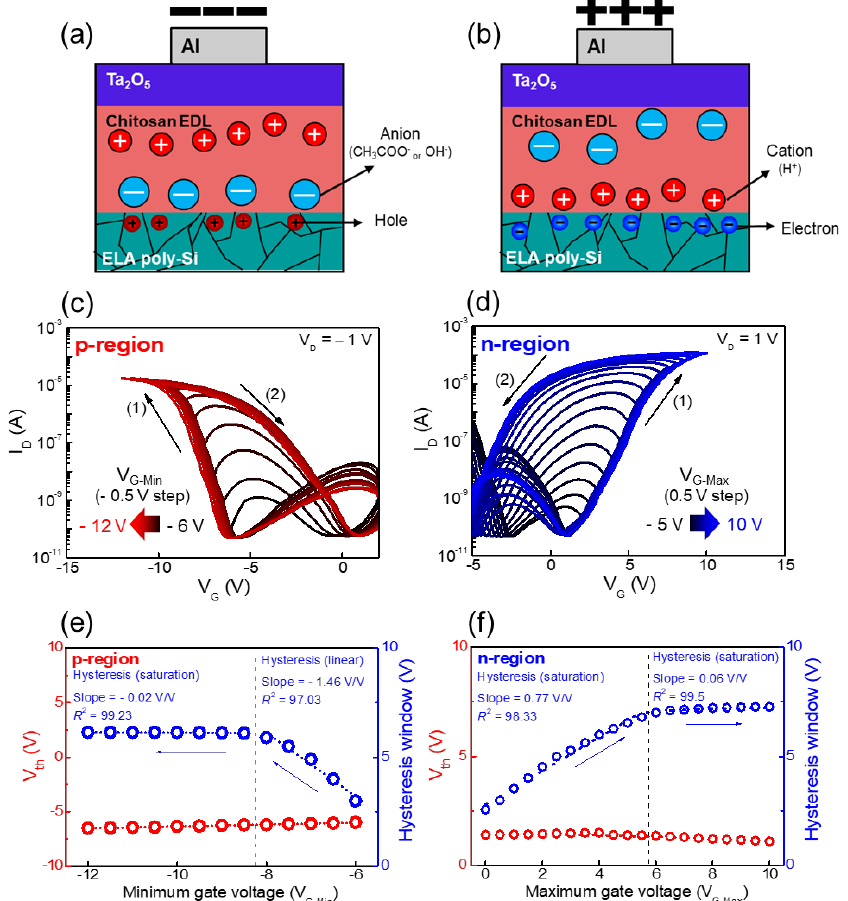
Figure 5. Mobile ion migration mechanism in the chitosan EDL of ambipolar chitosan synaptic transistor according to the ( a ) negative and ( b ) positive gate bias conditions. ( c ) p-region double-sweep transfer (I D − V G ) curves according to V G_min ( − 6 to − 12 V in − 0.5 V decrements). ( d ) n-region double-sweep transfer (I D − V G ) curves according to V G_max ( − 5 to 10 V in 0.5 V increments). V th and hysteresis window variation corresponding to ( e ) V G-min at p-region and ( f ) V G_max at n-region. As a form of short-term synaptic plasticity, the paired-pulse facilitation (PPF) char- acteristic represents the dynamic enhancement of neurotransmitters in biological neural synapses, involved in several neural tasks such as simple learning and encoding temporal information [52]. PPF is the degree of facilitation between the first and second